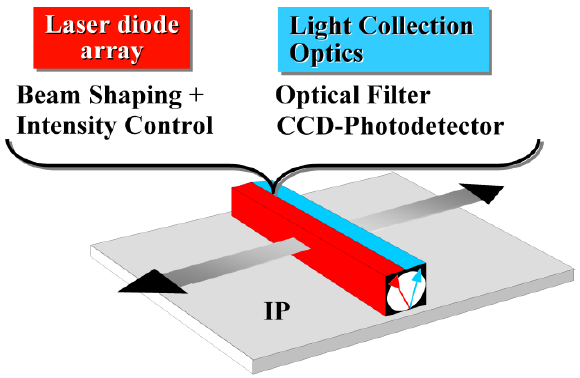
Figure 22. Schematic diagram of line-scanning principle (adapted from [77]).